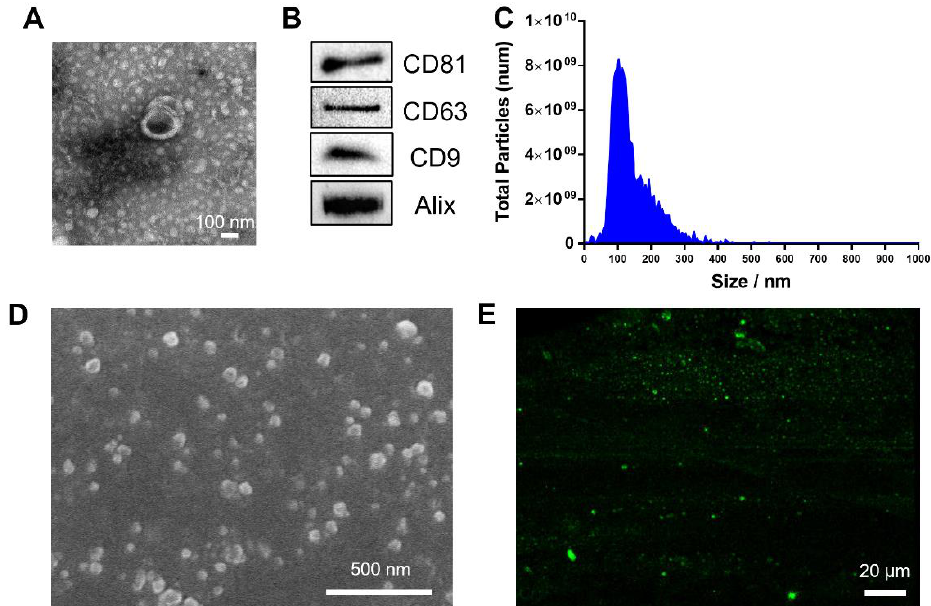
Figure 2. Characterization of MSC-derived EVs. ( A ) Representative TEM image of isolated EVs. ( B ) Western blot analysis showing the expression of specific markers in EVs. ( C ) The size distributions of EVs using Zetaview. ( D ) The representative SEM and ( E ) confocal scanning microscopy images of immobilized EVs on the surface of PMPR-EV.